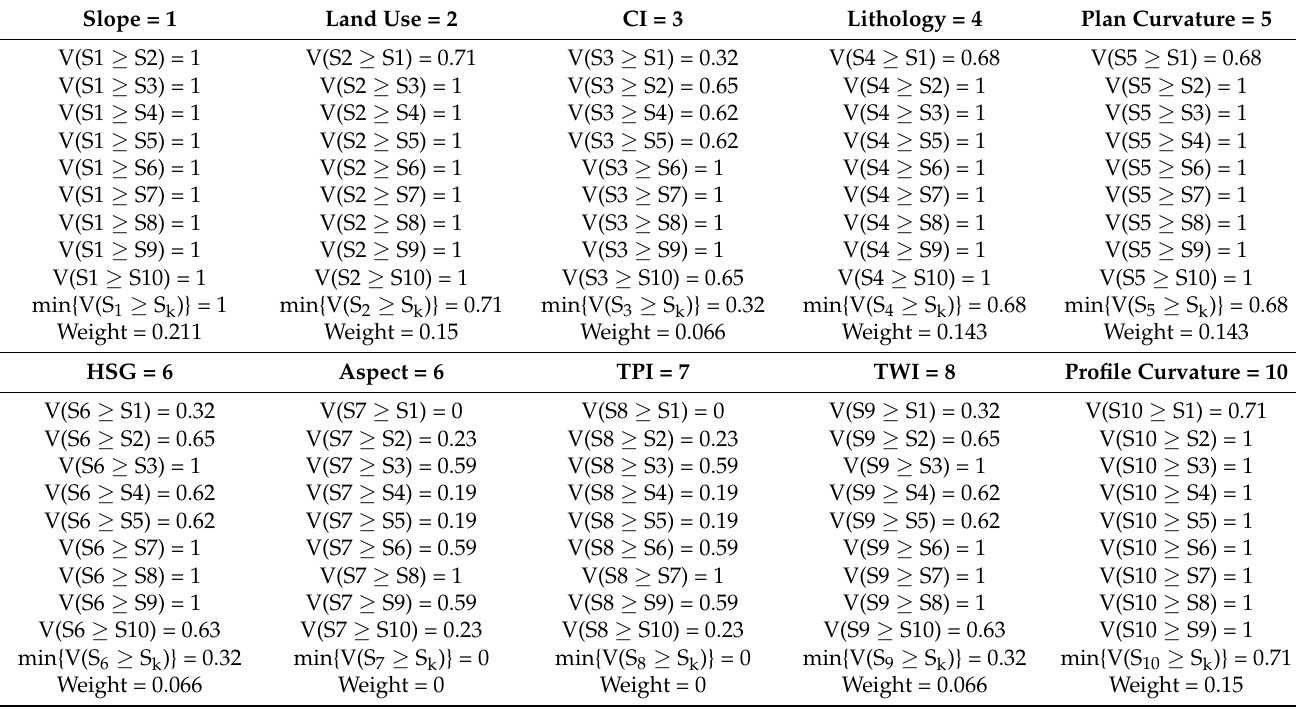
Table 3. The ordinate of the highest intersection point, the degree possibility for Triangular Fuzzy Numbers (TFNs), and the weights of the flash-flood